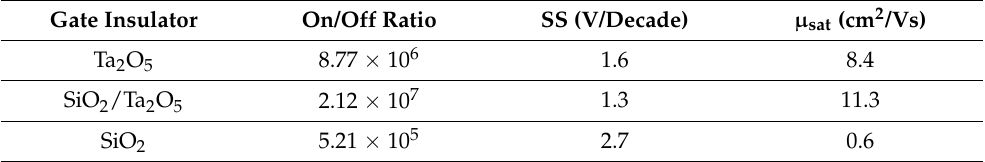
Table 1. Transistor parameters of the Ta 2 O 5 /a-IGZO and Ta 2 O 5 /SiO 2 /a-IGZO TFTs. Gate